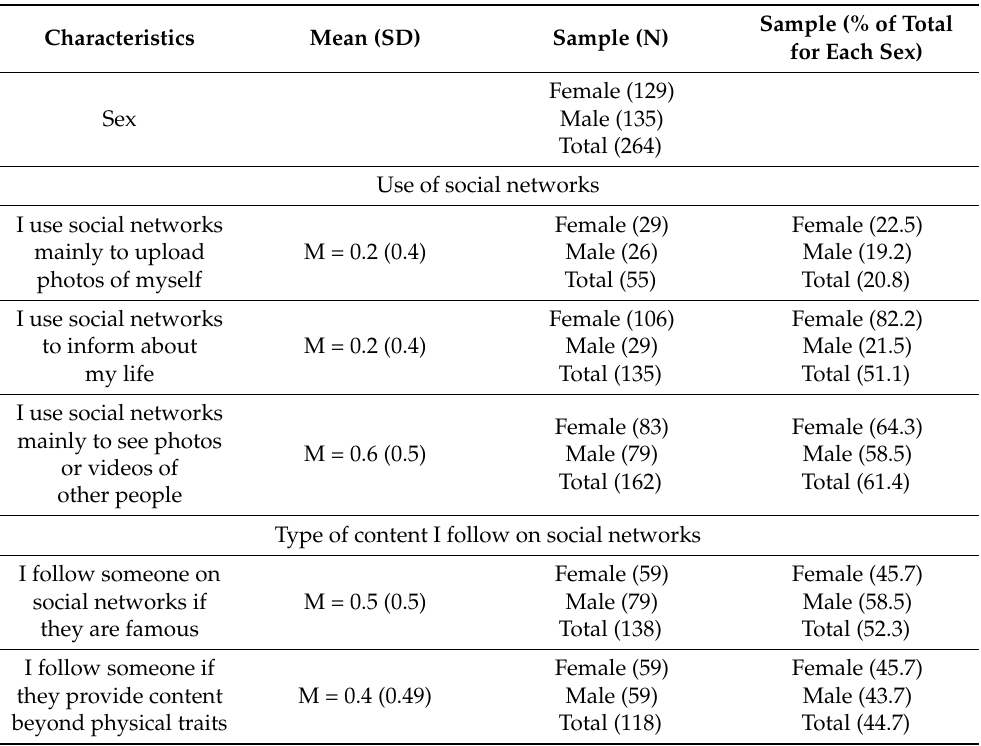
Table 2. Descriptive characteristics of the sample. Mean (SD) and differentiation by sex (N and %).